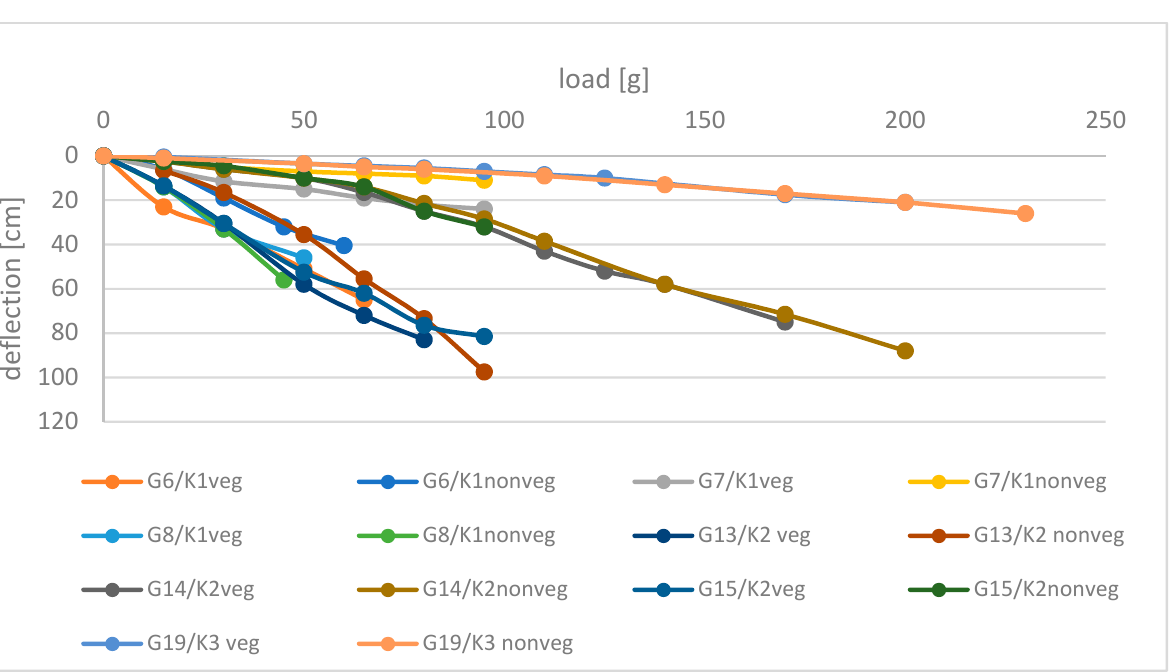
Figure 11. Figures of deflection arrows of selected branches of shrubs 1, 2, and 3, loaded at 150 cm above ground level (where Gx —branch number; Kx —shrub number).